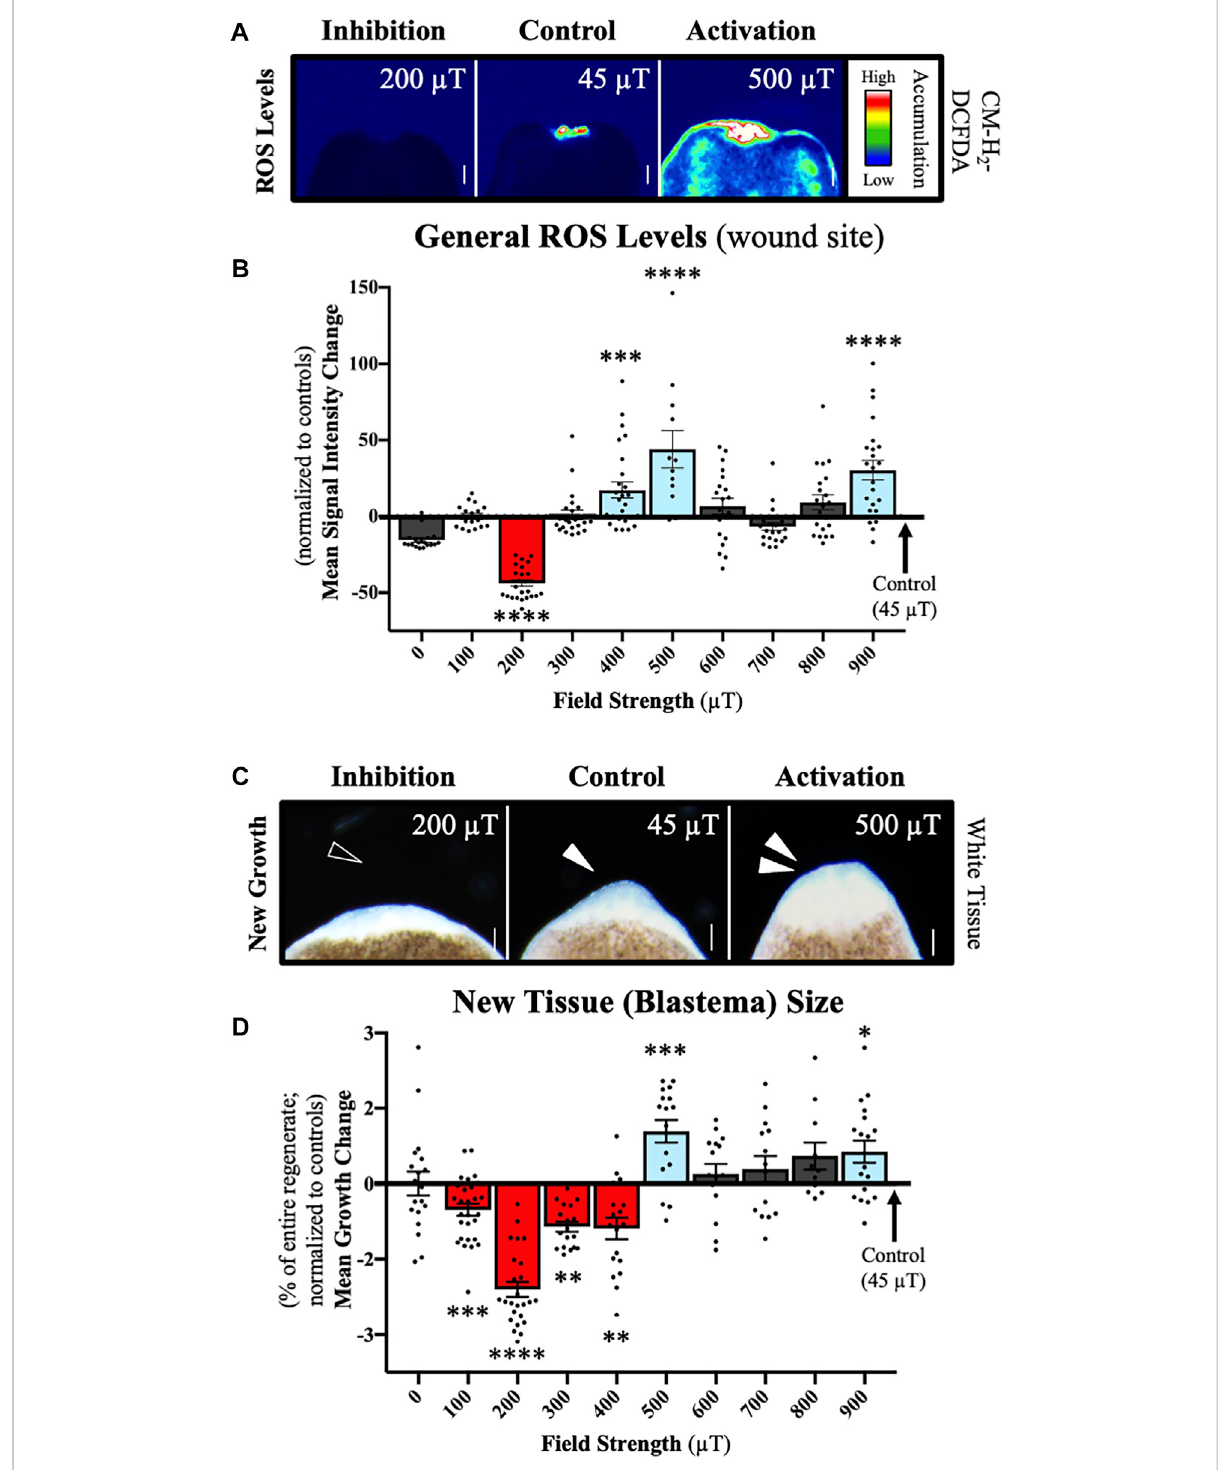
FIGURE 3 Weak MagneticFields (WMFs) Predictably Manipulate ROS Levels and Tissue Growth. Effects on planarian regeneration. (A) Representative fi eld strength-dependent effects on ROS accumulation at the anterior wound site 1 h after injury, where 200 µT inhibits and 500 µT increases ROS levels as compared to 45 µT controls. ROS visualized with a general oxidative stress indicator fl uorescent dye (CM-H 2 DCFDA) as a heat map of signal intensity: red/white/green = high ROS; blue/black = low/none. (B) Quanti fi cation of (A) showing changes in ROS levels (as compared to 45